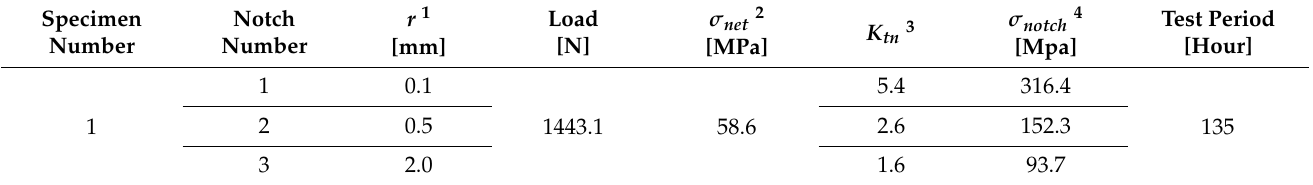
Table 2. Test conditions of three specimens (specimen 1, 2, and 3) and the maximum stress in the notch ( σ notch ).